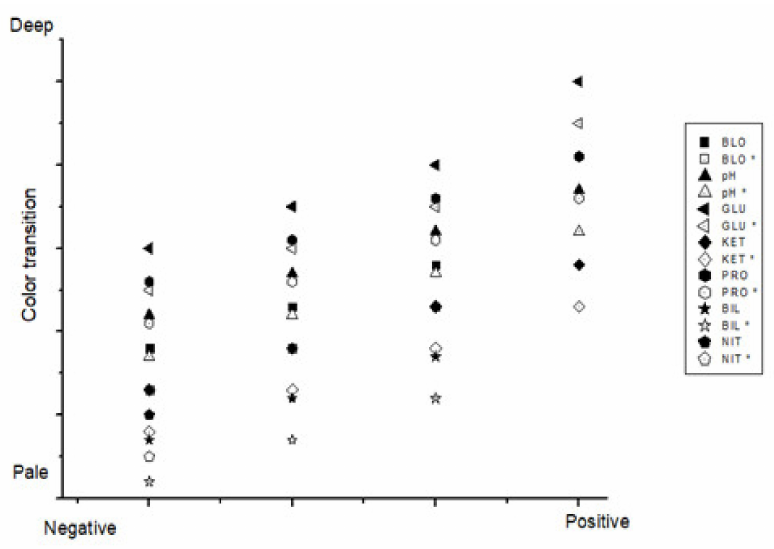
Figure 6. Comparison for the analysis of urine dipstick test result